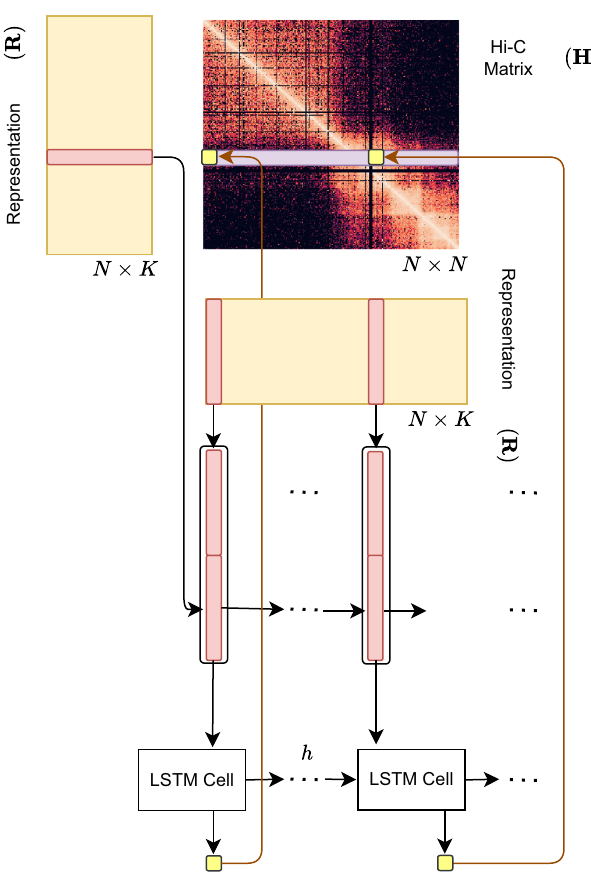
Fig. 2 Overview of the Hi-C-LSTM model. A trained Hi-C-LSTM model consists of a K -length representation R i for each genomic position i and LSTM connection weights (see the “ Methods ” section). To predict the contact vector of a position i with all other positions, the LSTM iterates across the positions j ∈ {1 … N }. For each ( i , j ) pair, the LSTM takes as input the concatenated representation vector ( R i R j ) and outputs the predicted Hi-C contact probability H i , j . The LSTM hidden state h is carried over from ( i , j ) to ( i , j + 1). This process is repeated for all N rows of the contact map by reinitializing the LSTM states. The LSTM and the representation matrix are jointly trained to minimize the reconstruction